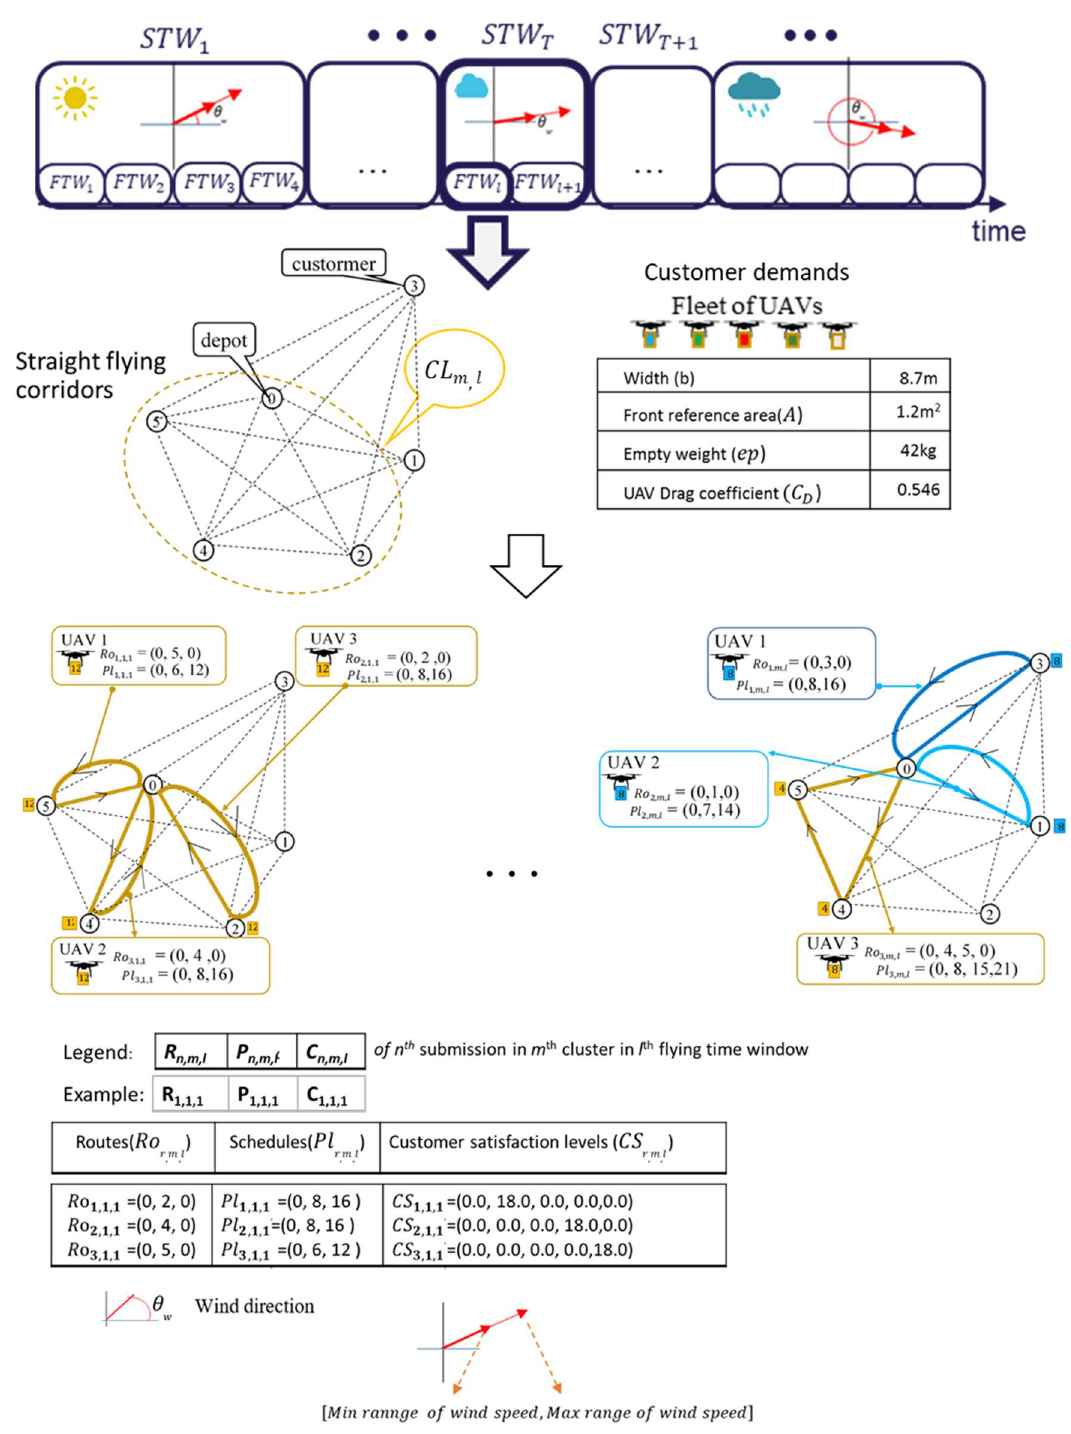
Figure 3. Problem modeling illustration.